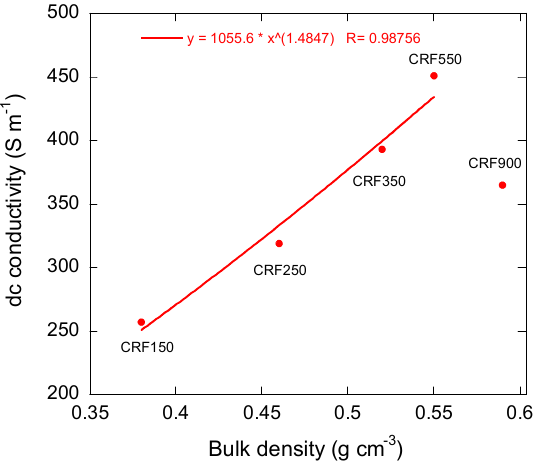
Figure 11. Electrical conductivity of cellular carbon monoliths. The curve corresponds to the fit of Equation (9) to the first four data points.